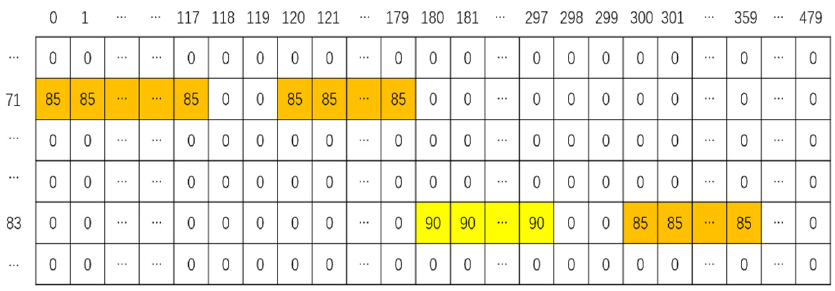
Figure 8. Encoded bar matrix.